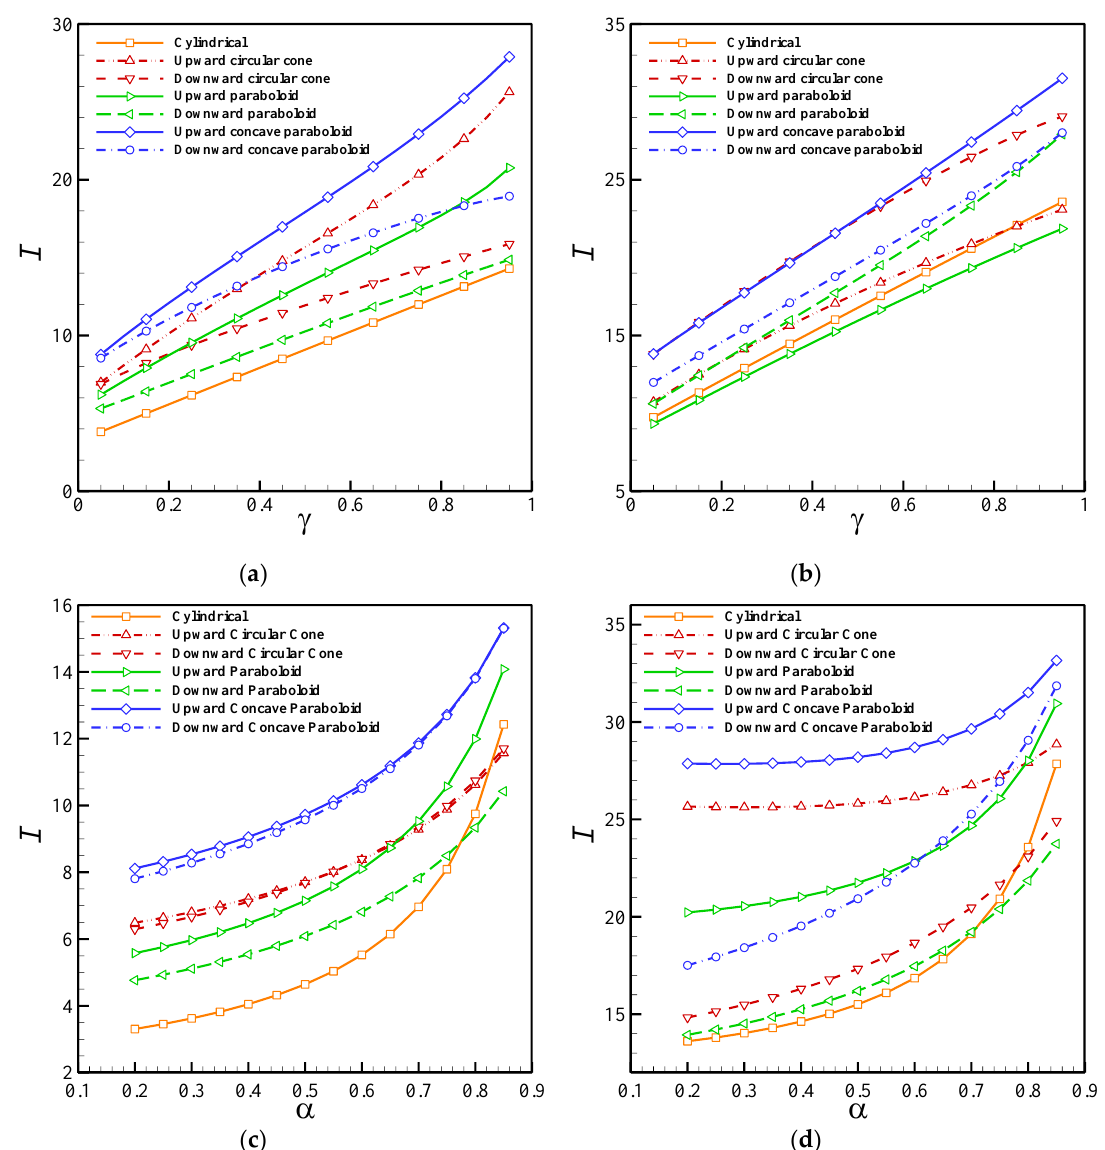
Figure 8. Dependency of the steady-state biosensor current on the perforation level: ( a ) γ = 0.05, ( b ) γ = 0.95. The enzyme filling level: ( c ) α = 0.35, ( d ) α =